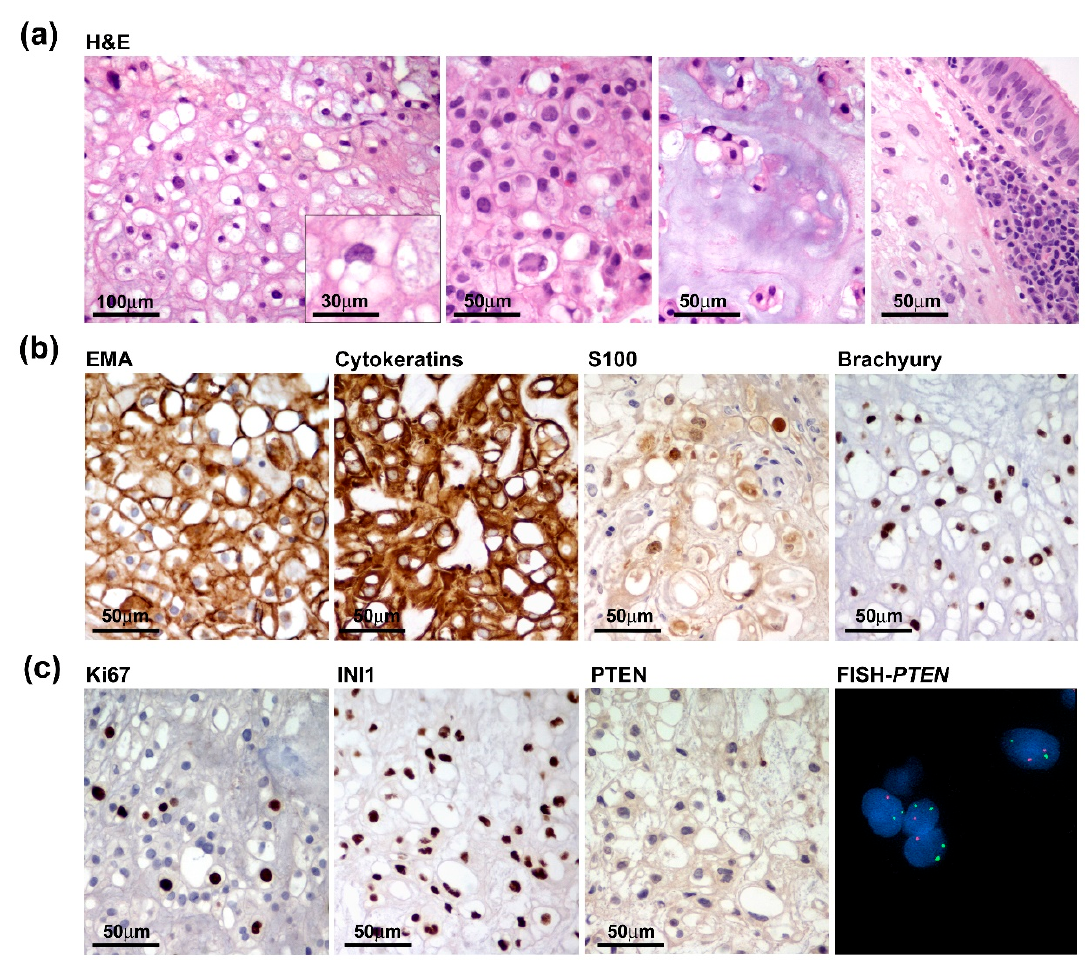
Figure 3. Pathological features of the primary tumour. ( a ) Tumour was composed of nests of large epithelioid cells with light eosinophilic ( left two panels) or bubbly vacuolated cytoplasm (physaliphorous cells) (inset) with focal chondroid differentiation and evidence of sphenoidal bone infiltration with extension to the adjacent mucosa ( right panels). ( b ) Tumour cells diffusely express chordoma markers such as EMA, Cytokeratins, S100 and Brachyury. ( c ) Proliferation index, assayed by Ki67/Mib1 immunostaining, only focally reached 7–8% and INI1 expression was retained ( left panels), while PTEN was negative and hardly detected consistent with PTEN heterozygous deletion as assayed by FISH analysis ( right